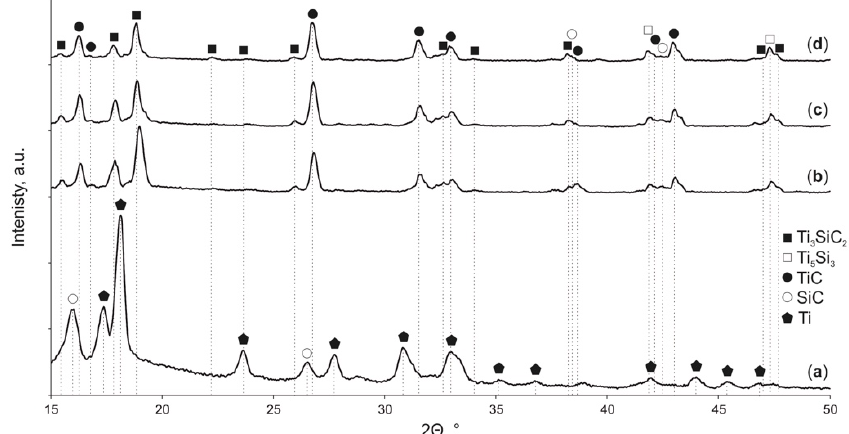
Figure 3. X-ray diffraction spectra of: Ti/SiC HEBMed powder ( a ); composite SPSed at 1350 °C ( b ); composite SPSed at 1400 °C ( c ) and composite SPSed at 1450 °C ( d ).